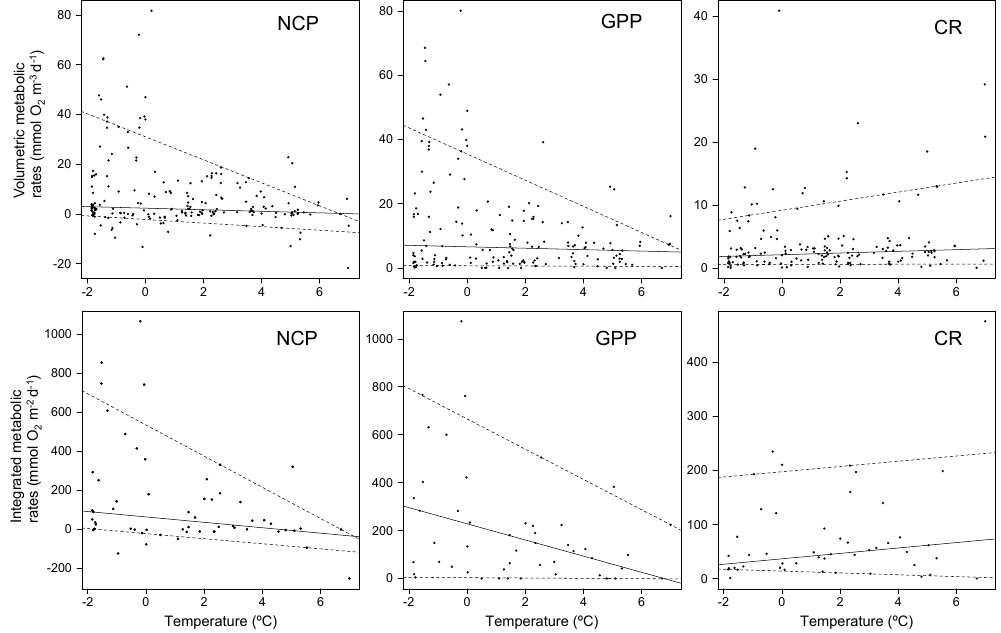
Fig. 6. Relationship between volumetric and integrated metabolic rates and water temperature. Upper panels show volumetric metabolic rates: volumetric net community production (NCP), volumetric gross primary production (GPP), volumetric community respiration (CR). Lower panels show integrated metabolic rates: integrated NCP, integrated GPP and integrated CR. Solid lines represent the fitted regression for the median or the 50% quartile. Dashed lines represent the fitted regression for the 90 and 10% quantiles. Statistics for the regression lines are summarized in Table S3.